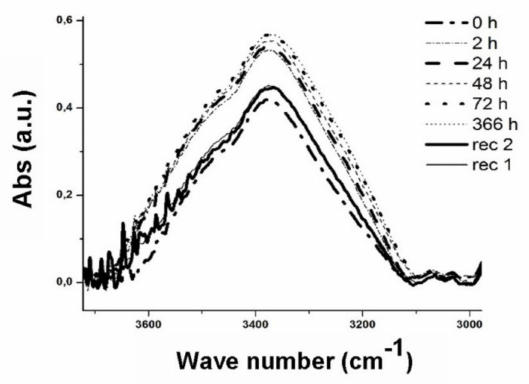
Figure 7. IR spectrum of the -OH signal for uncoated samples at di ff erent ageing